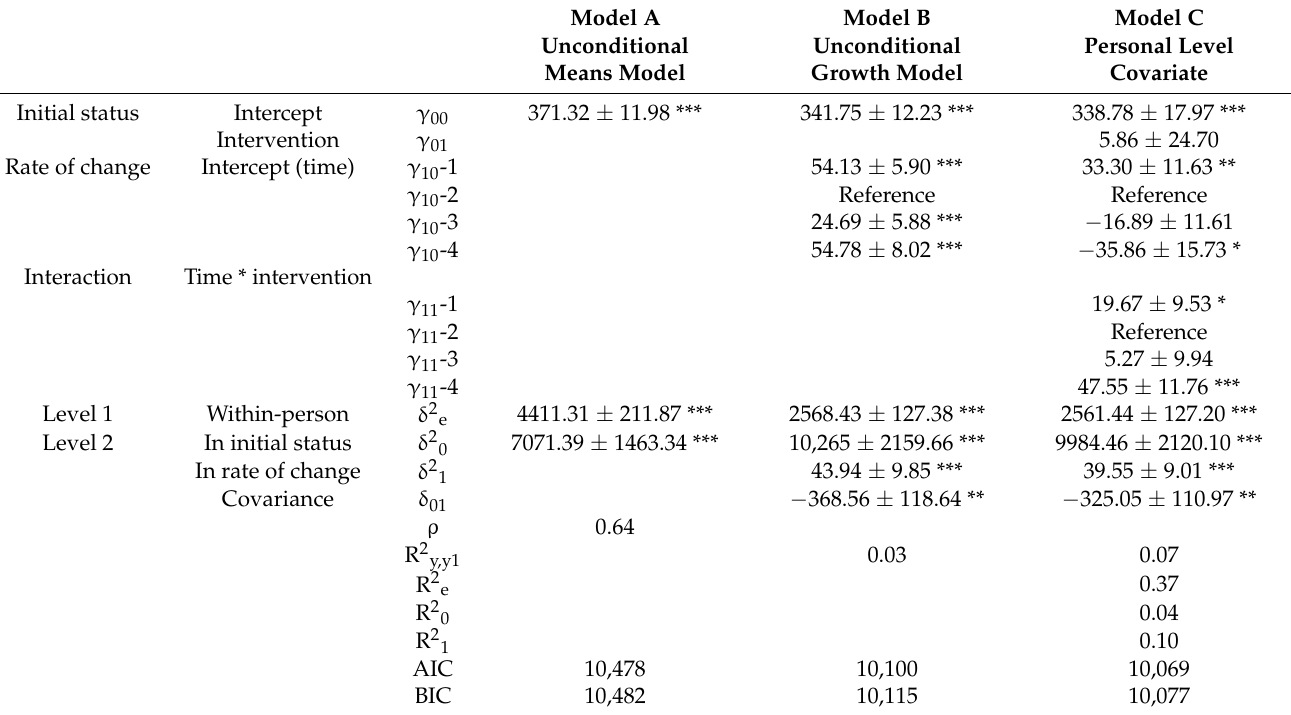
Table 3. Mixed model analyses of variation of light- to vigorous-intensity physical